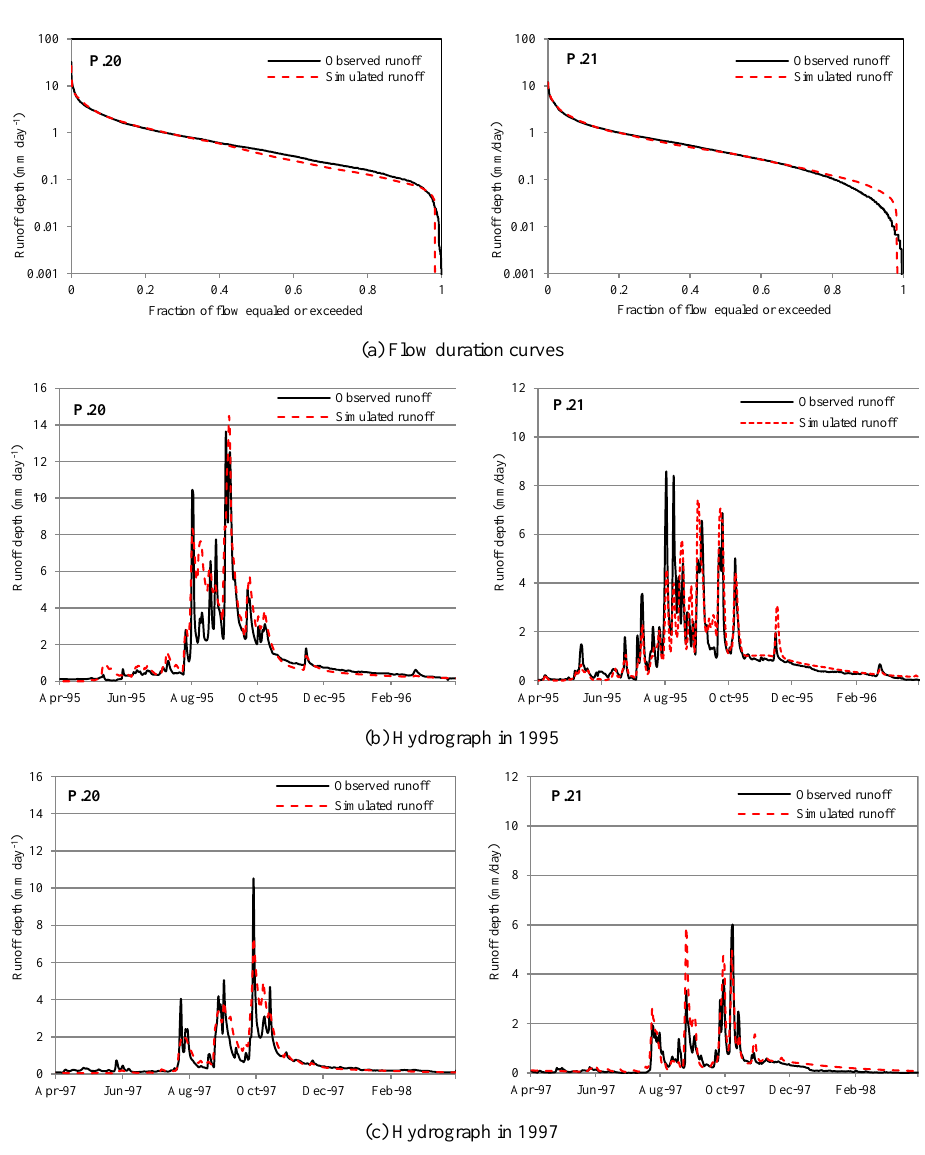
Figure 5. Examples of flow duration curves and simulated hydrographs using FLEX at runoff stations P.20 and P.21. Table 6. FLEX parameters calibrated at eight runoff stations located in the